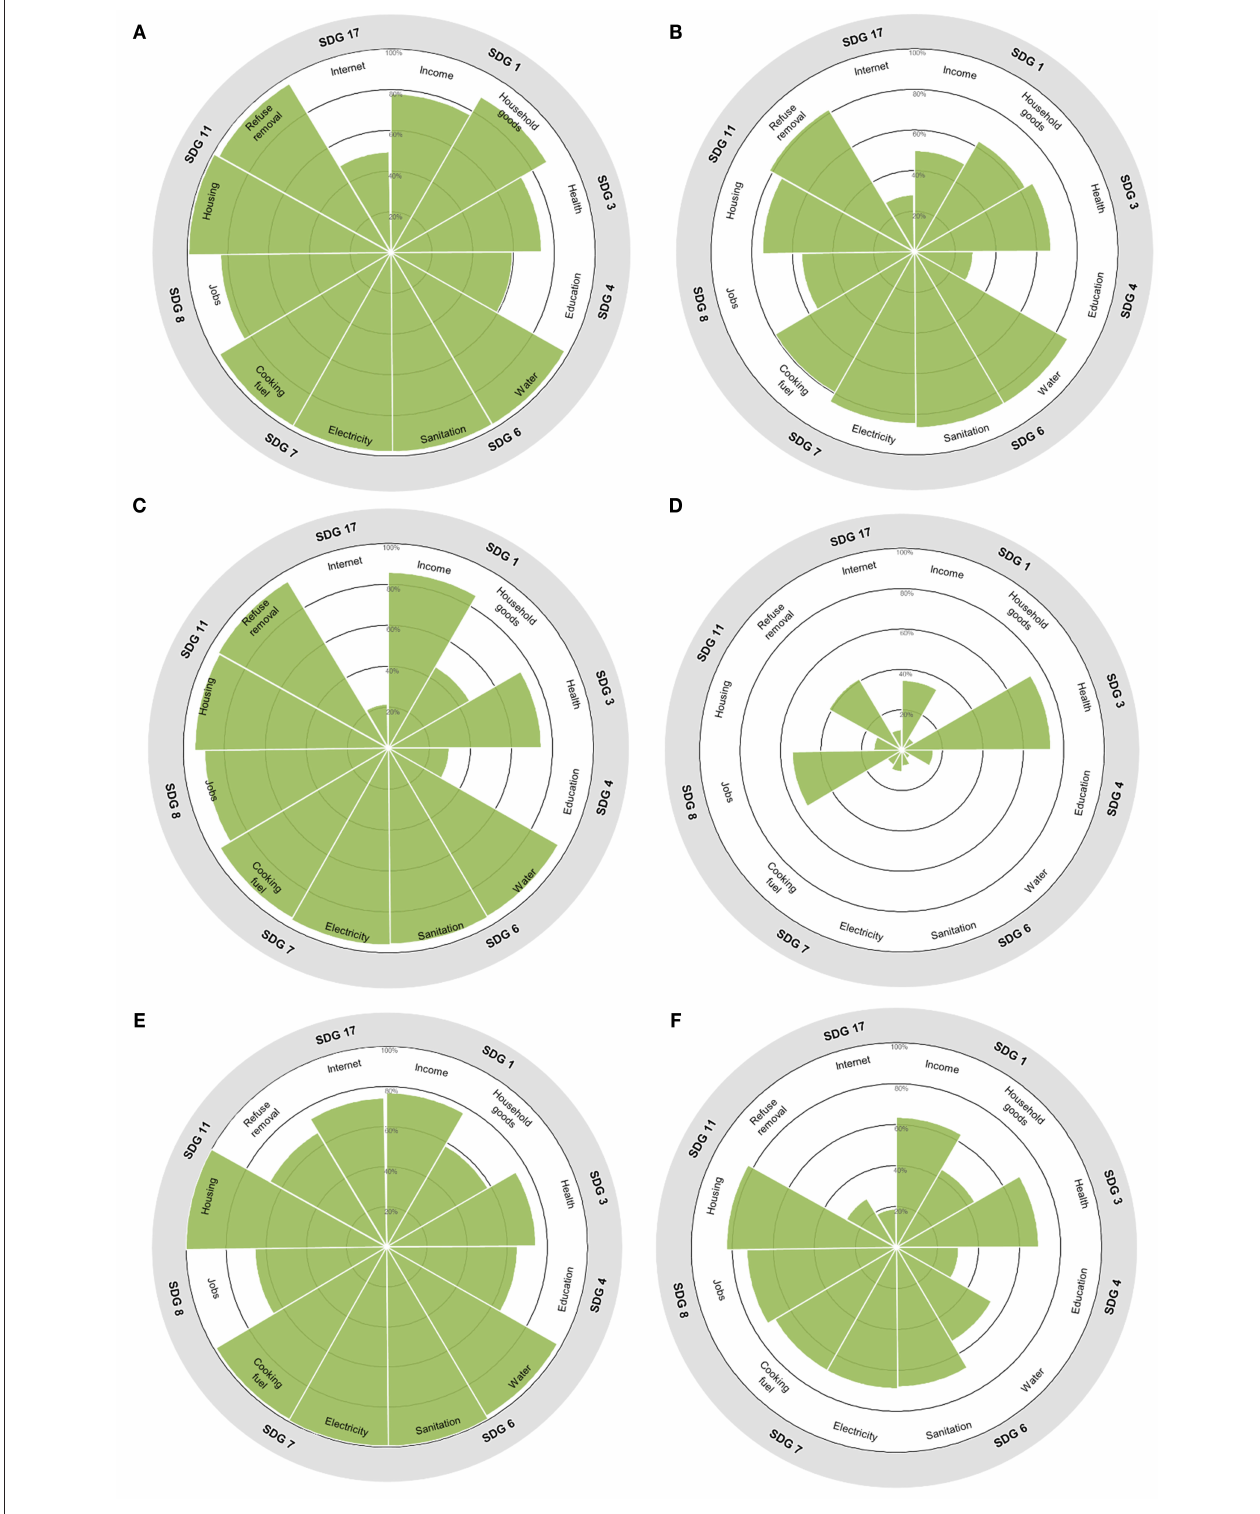
FIGURE 6 | SDG barometers for the Far West Rand (A) towns, (B) townships, (C) mine villages, (D) informal settlements, (E) industrial areas, and (F) rural farming areas.